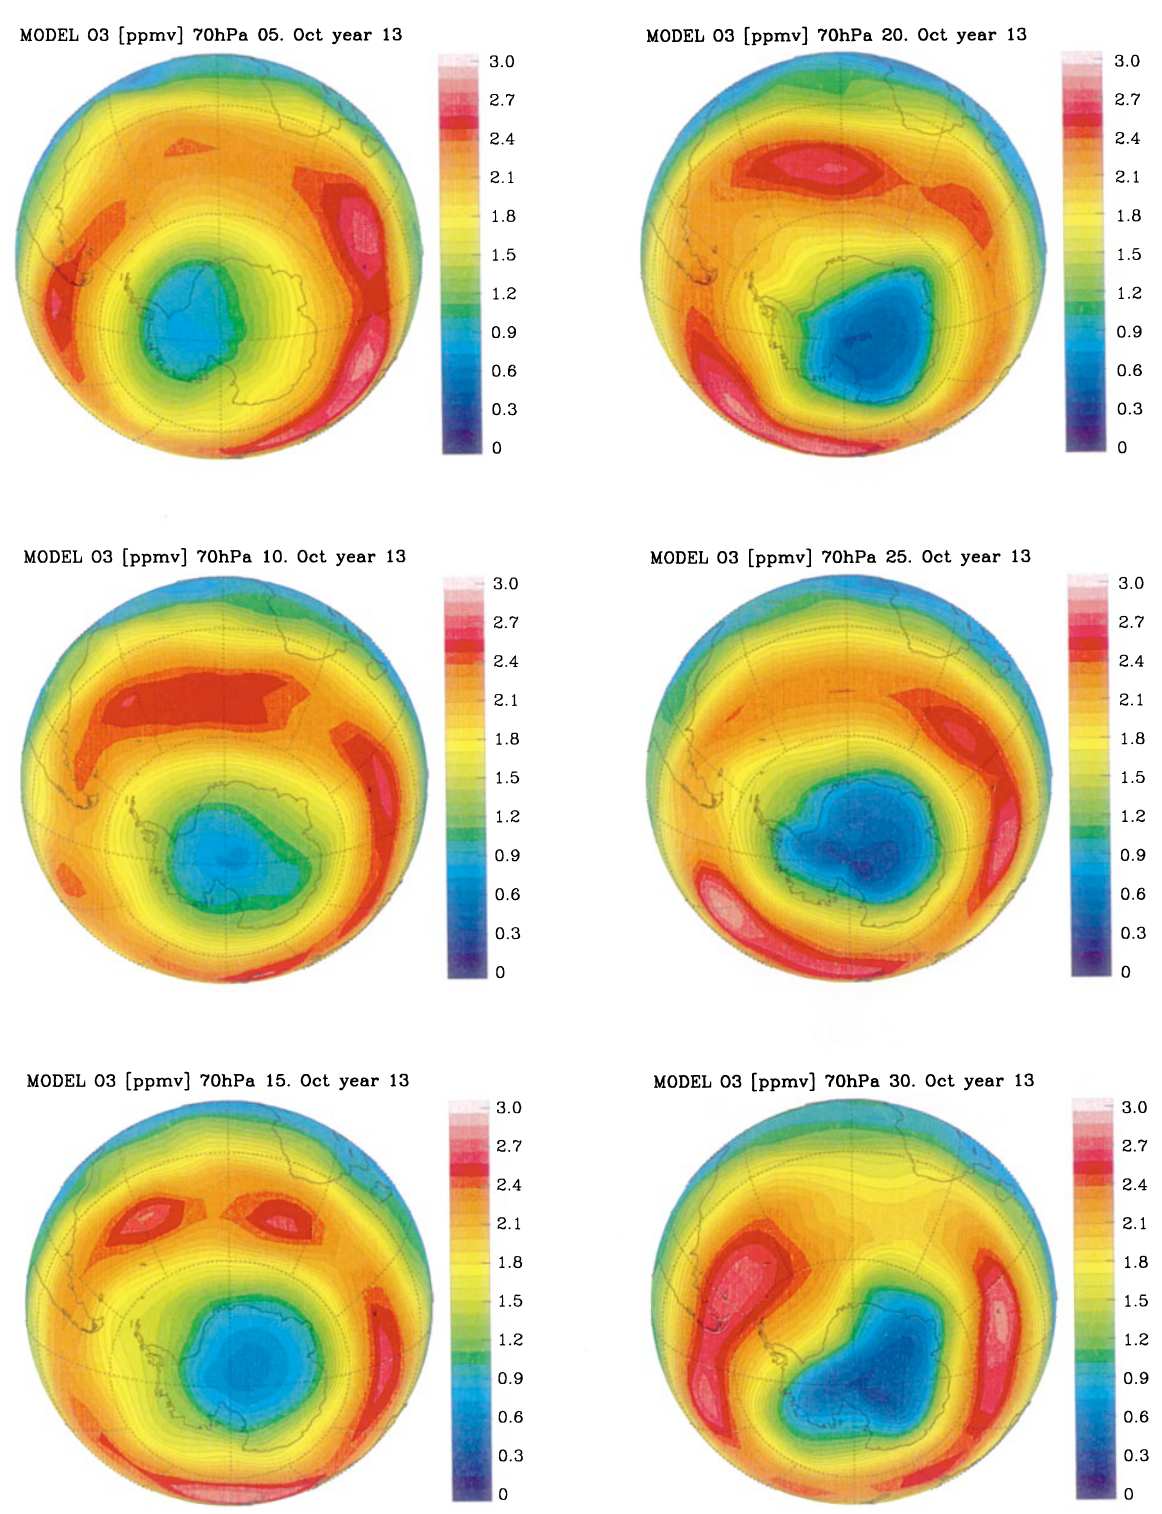
Fig. 12. Temporal development of the Antarctic ozone hole during October for model year 13. Ozone charts (in ppmv) at 70 hPa for 5 to